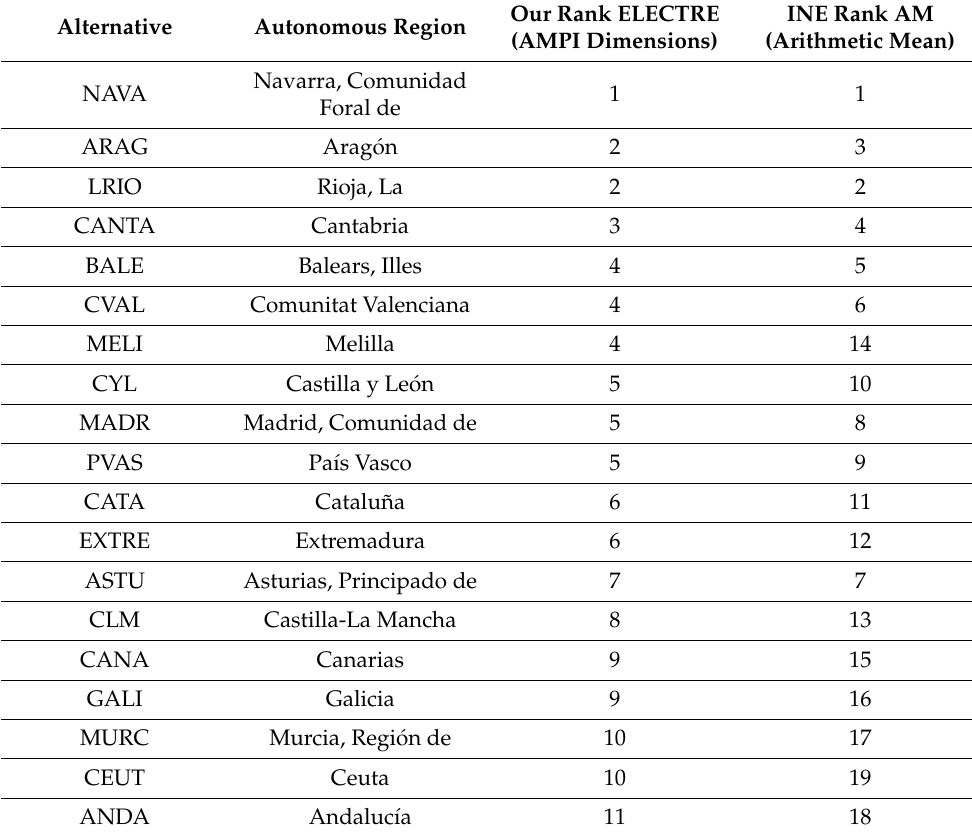
Table 5. Comparison between our result (ELECTRE III) and INE result (arithmetic mean). Alternative Autonomous Region